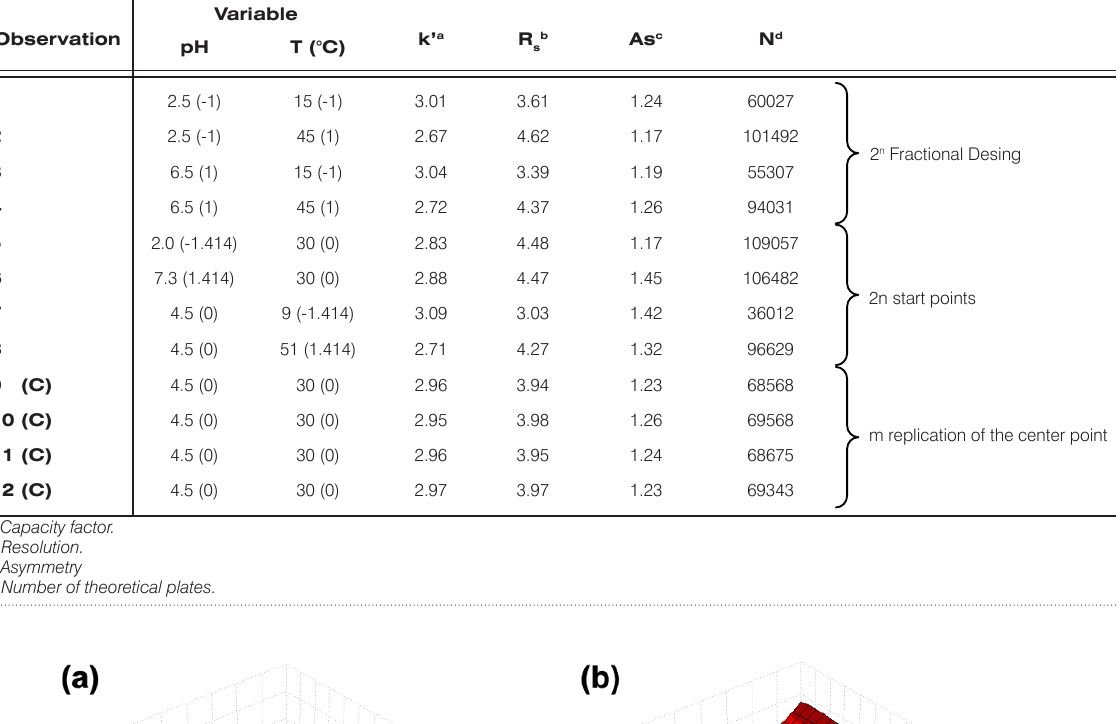
Table 1. Exemplary Central Composite Design (CCD).